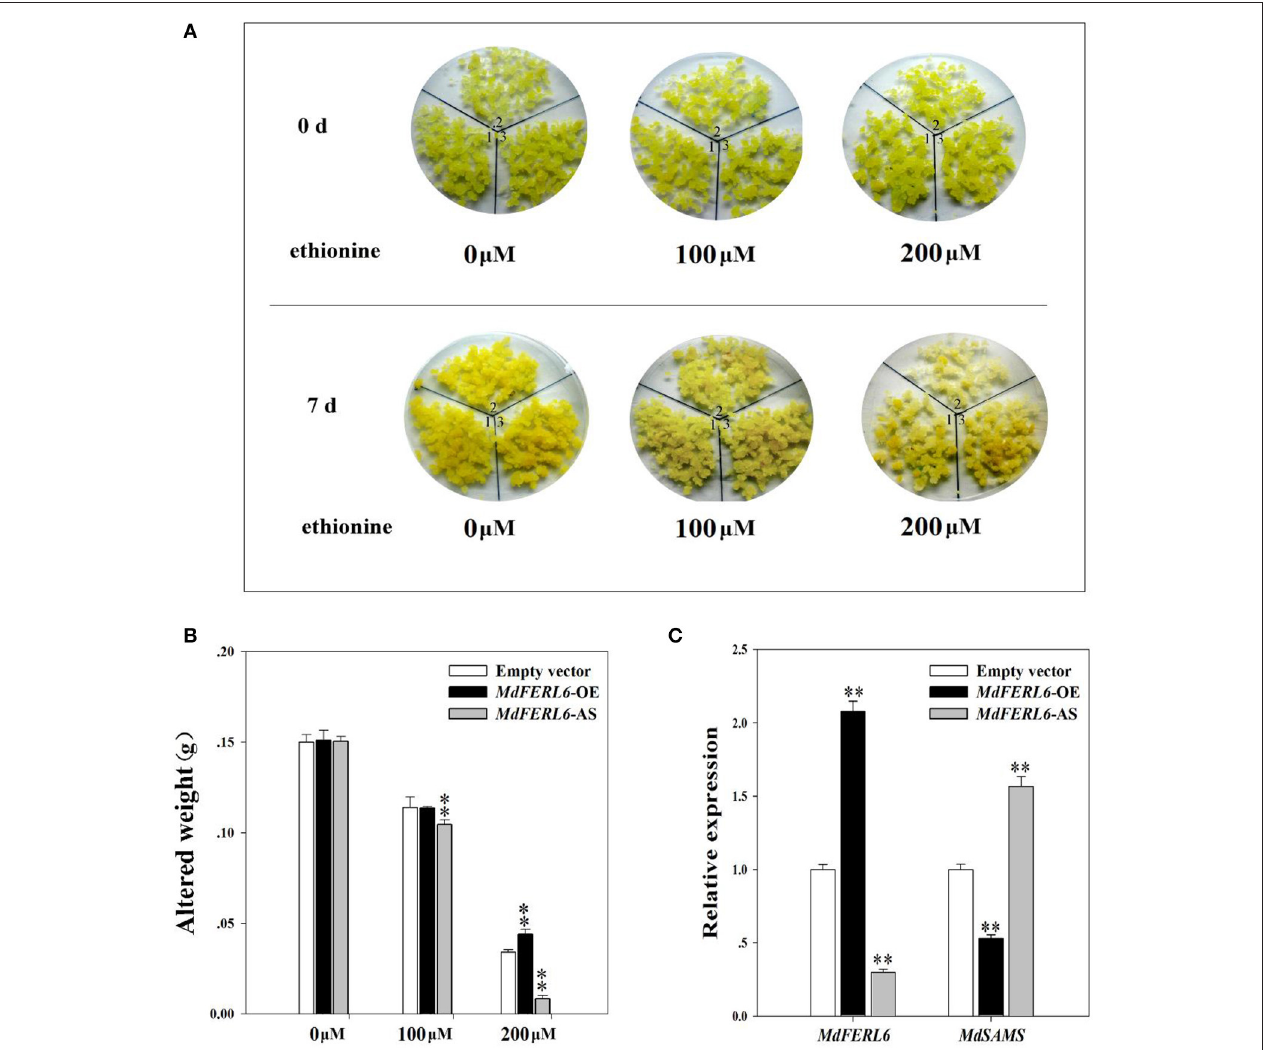
FIGURE 8 | Ethionine activity assay. (A) Ethionine altered the growth status of apple calli. Apple calli transfected with empty vector (1); MdFERL6 -AS (2); and MdFERL6 -OE (3). (B) Measurement of calli weight. Transfected apple calli were weighed before treatment (0 day, and were then cultivated with ethionine for 7 days. The increase in weight between 0 and 7 days is indicated on the y-axis. Values are means + SD of three biological replicates. Single asterisks denote a significant difference at P < 0.05 using Student’s t -test; double asterisks denote a significant difference at P < 0.01 using Student’s t -test. (C) Gene expression of MdFERL6 and MdSAMS were detected in apple calli cultivated in 200 µ M ethionine for 7 days. Values are means + SD of three biological replicates. Single asterisks denote a significant difference at P < 0.05 using Student’s t -test; double asterisks denote a significant difference at P < 0.01 using Student’s t